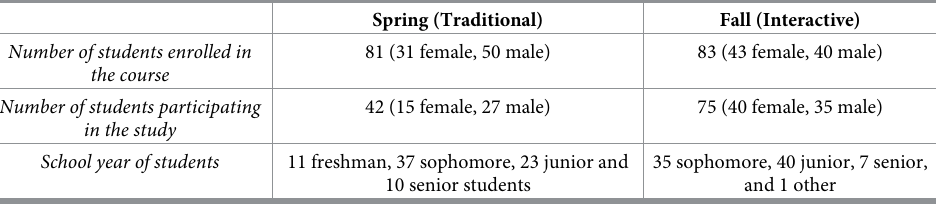
Table 1. Student characteristics for the two course